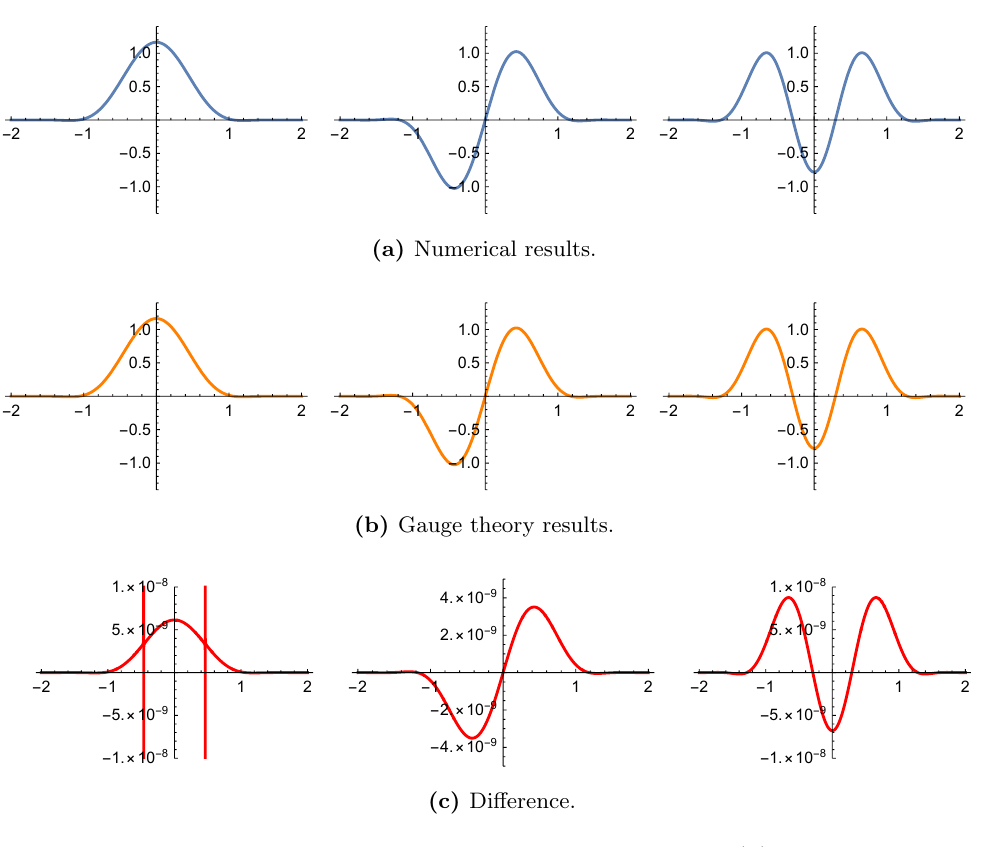
Figure 15. Level n = 0 ; 1 ; 2 gauge theory 2-particle Baxter solution q ( (cid:27) ) for ! 1 = 2 (cid:0) 1 4 , ! 2 = 2 1 4 , m 0 = 0.